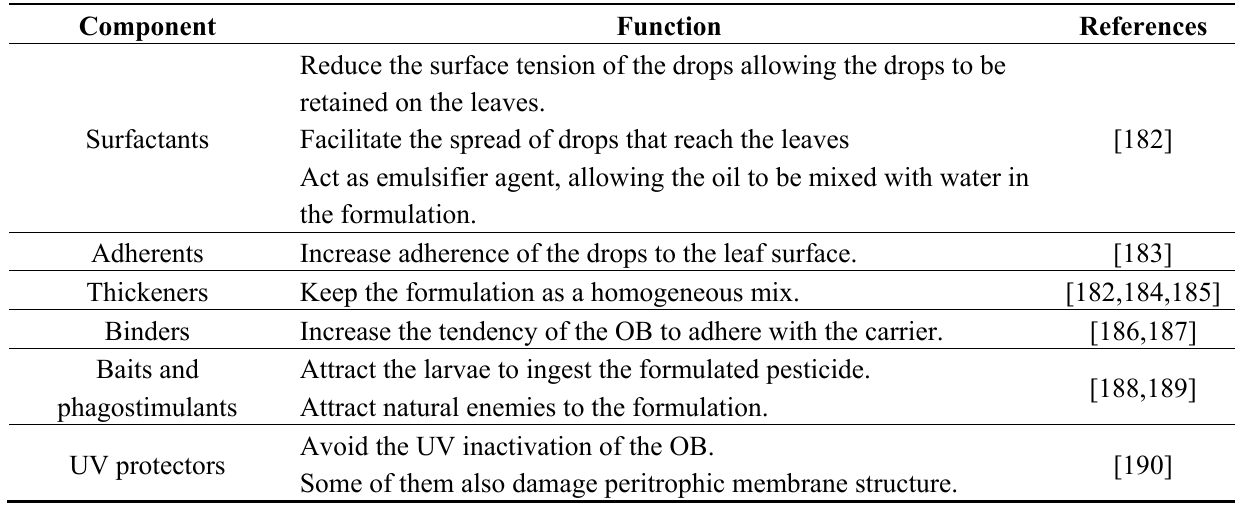
Table 2. Additives commonly used in baculovirus pesticide